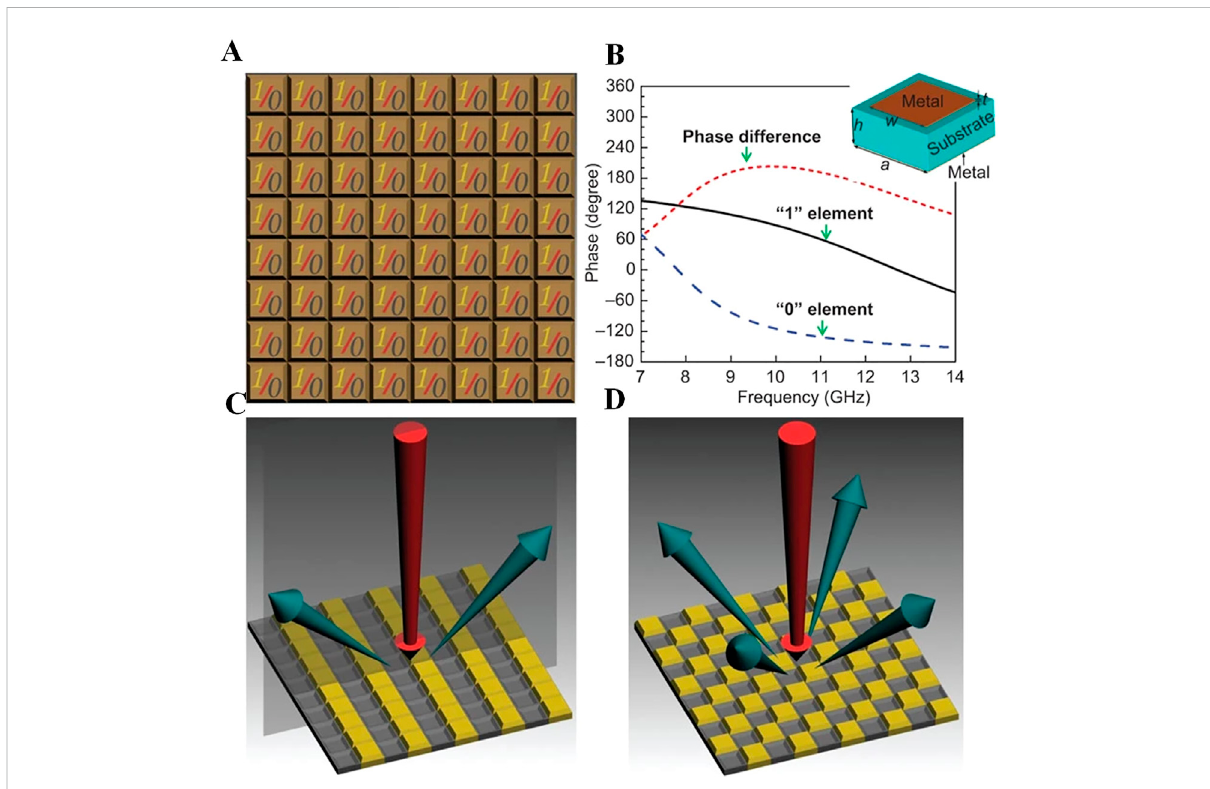
FIGURE 2 The 1-bit digital metasurface and coding metasurface. (A) The 1-bit digital metasurface is composed of only two types of elements: “ 0 ” and “ 1. ” (B) A square metallic patch unit structure (inset) to realize the “ 0 ” and “ 1 ” elements and thecorresponding phase responses in a range of frequencies. (C,D) Two 1-bit periodic coding metasurfaces to control the scattering of beams by designing the coding sequences of “ 0 ” and “ 1 ” elements: (C) the 010101 ... /010101... code and (D) 010101 ... /101010...